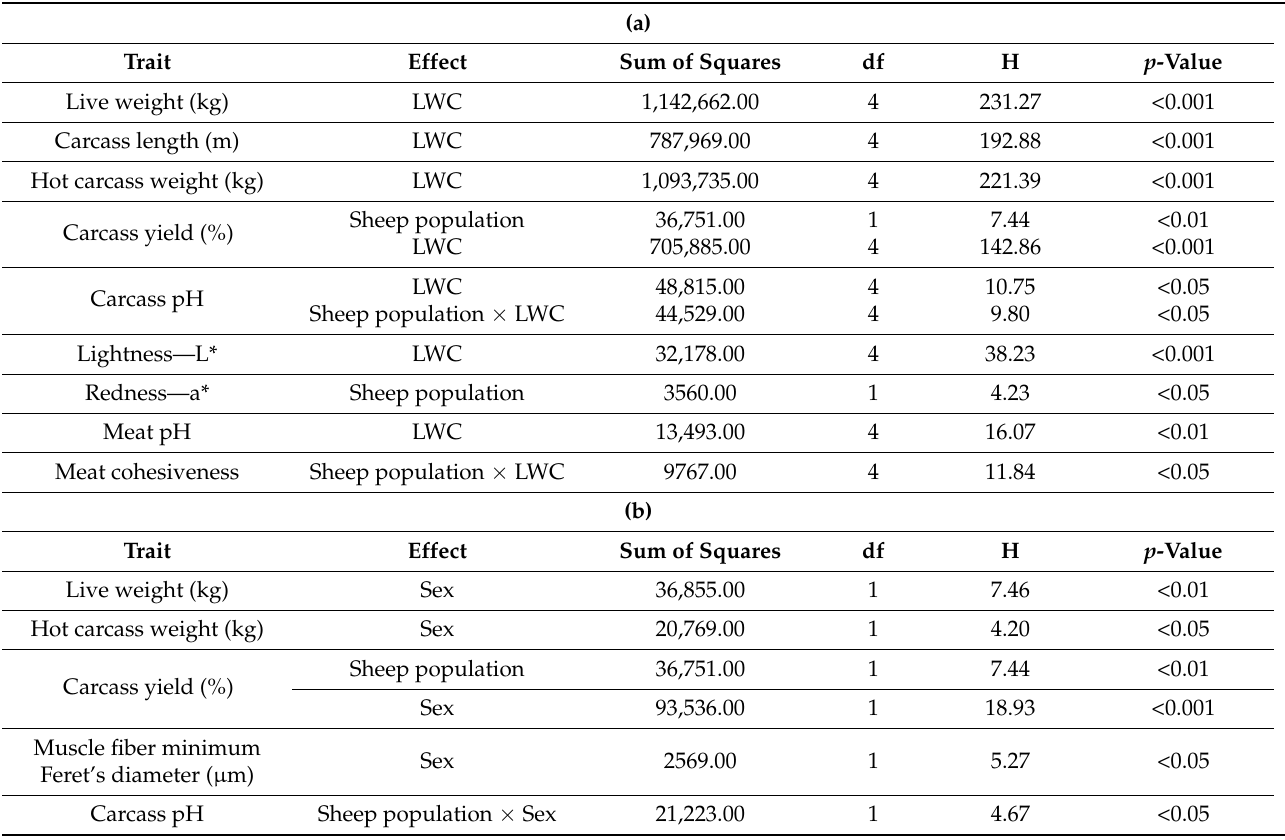
Table 7. ( a ) . Statistically significant effects ( p < 0.05) of sheep population (fat-tailed or thin-tailed sheep), live-weight category (LWC) and their interaction on studied traits, as estimated by